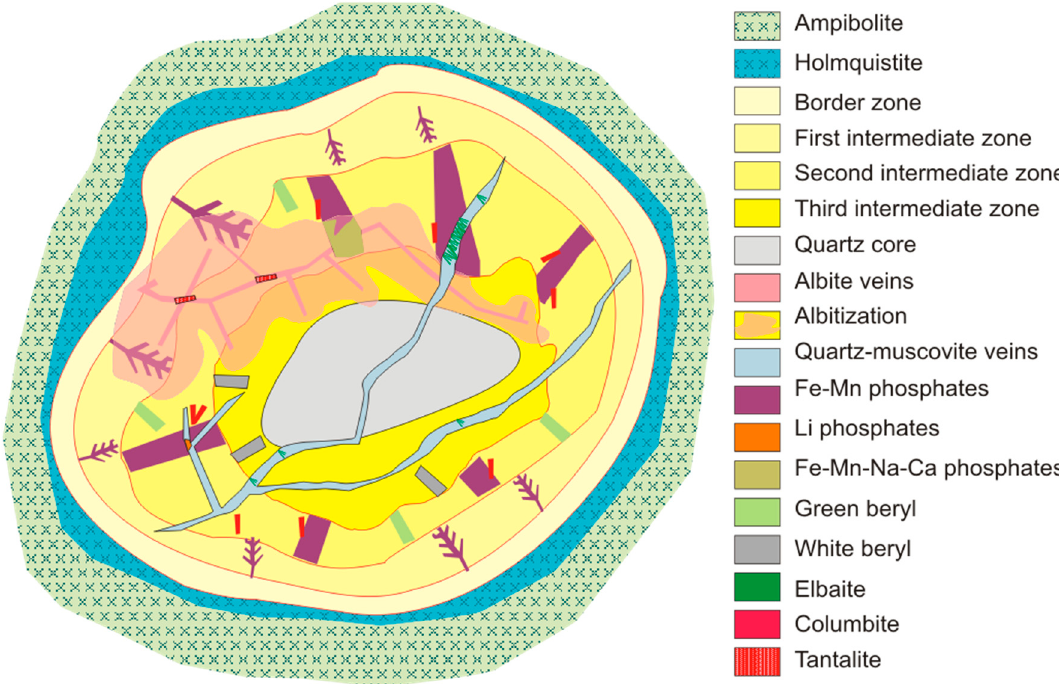
Figure 7. Conceptual scheme (not to scale) of the various pegmatite units in type-IV pegmatites and distribution of the most significant minerals.